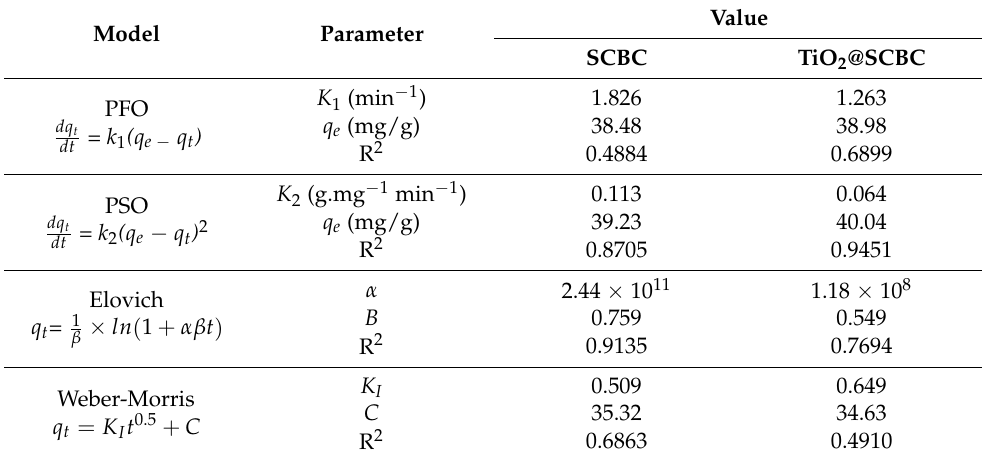
Table 7. Kinetics of the adsorption of BALX onto SCBC and TiO 2 @SCBC.